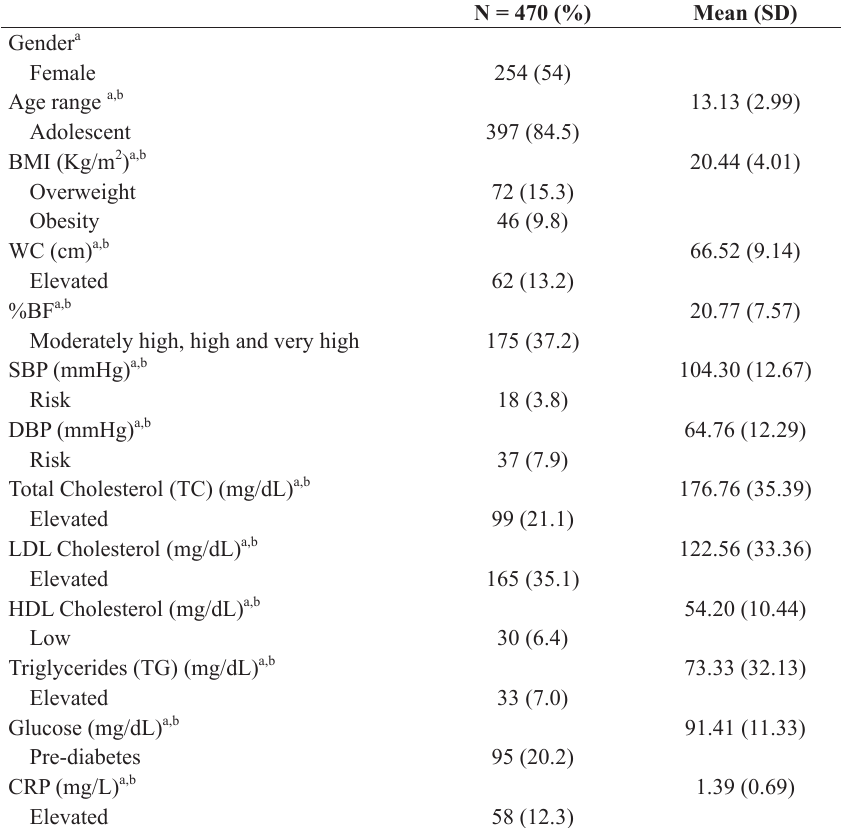
Descriptive characteristics of the